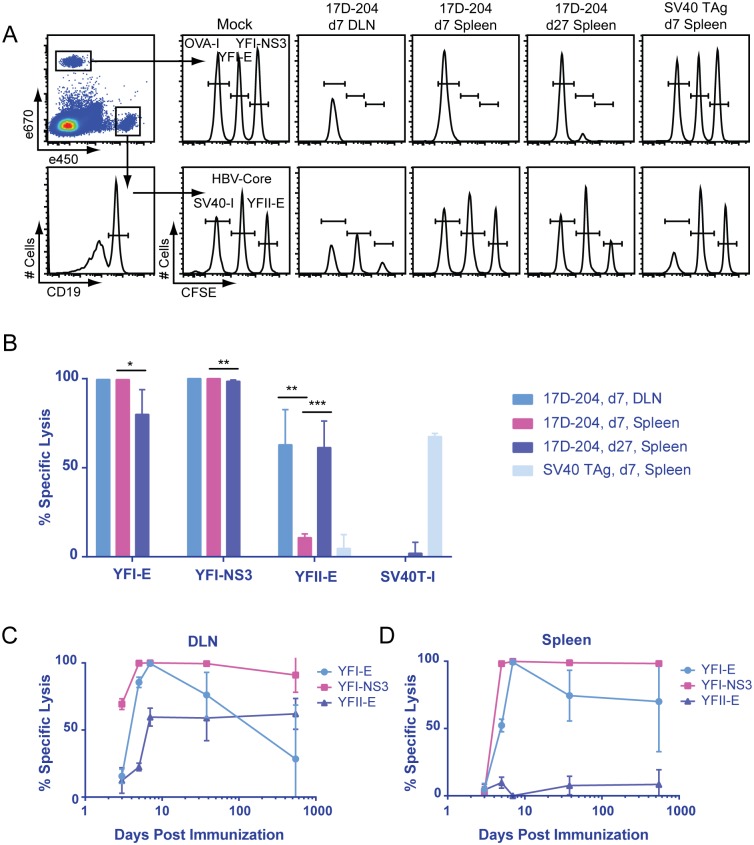
17D-204-specific T cells are cytolytic.5–6 week old mice were immunized s.c. with 17D-204 or intraperitoneally with cells immortalized by the SV40 virus. Splenocytes from a naive mouse were loaded with the indicated peptides, fluorescently labeled, mixed, and adoptively transferred into the immunized mice. At the indicated times post vaccination, in-vivo cytotoxicity directed against splenocytes loaded with the indicated peptides was evaluated by (A) the displayed flow cytometric gating strategy. (B-D) Specific lysis was calculated as described in the methods. Results are representative of two experiments (n = 3–5 for d3-d38 p.i. and n = 2 for d547). Data are displayed as mean ± SD for individual animals. ***, p<0.001; **, p<0.01; *, p<0.05 as determined by Student's t-test.